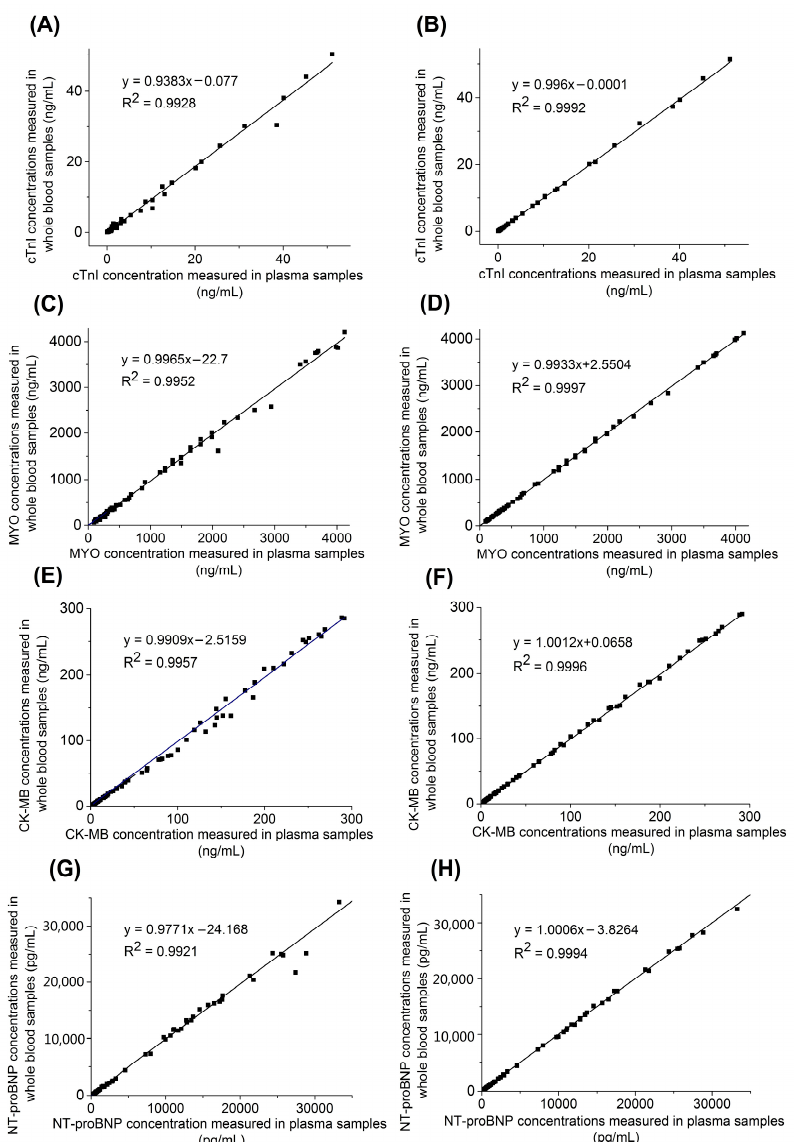
Figure 3. Comparison studies using whole blood samples and corresponding plasma samples for cTnI detection without HCT correction ( A ) and with HCT correction ( B ), for MYO detection without HCT correction ( C ) and with HCT correction ( D ), for CK-MB detection without HCT correction ( E ) and with HCT correction ( F ), for NT-proBNP detection without HCT correction ( G ) and with HCT correction ( H ).